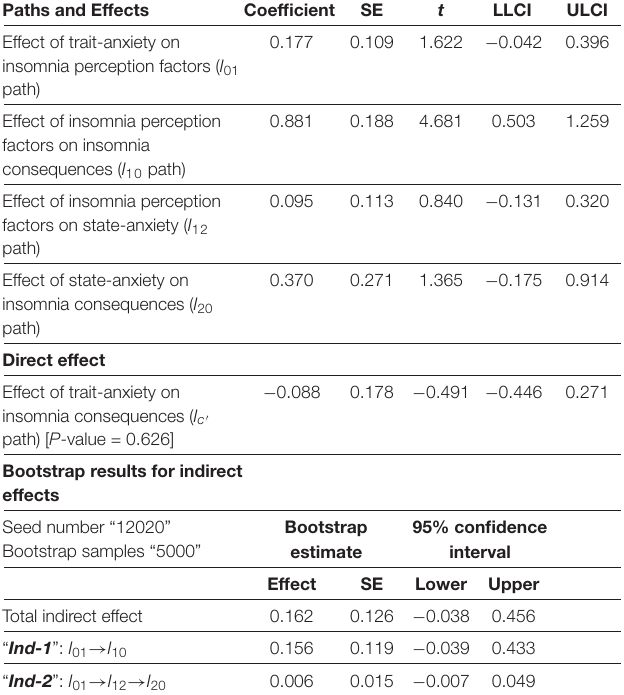
TABLE 4 | Mediator model of insomnia in neutral insomnia